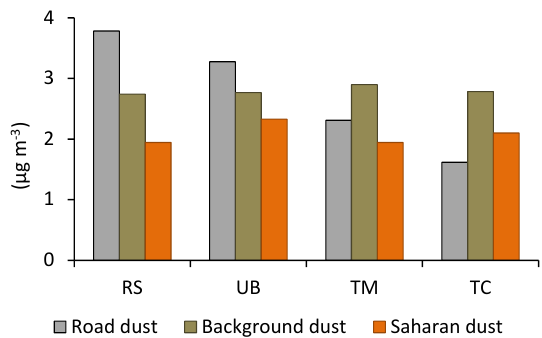
Figure 7. Average sources contributing to the mineral dust load dur- ing SAPUSS at the four monitoring sites RS, UB, TM and TC. Min- eral background dust contributes on average 2.8µgm − 3 , road dust 2.7µgm − 3 and Saharan dust 2.1µgm − 3